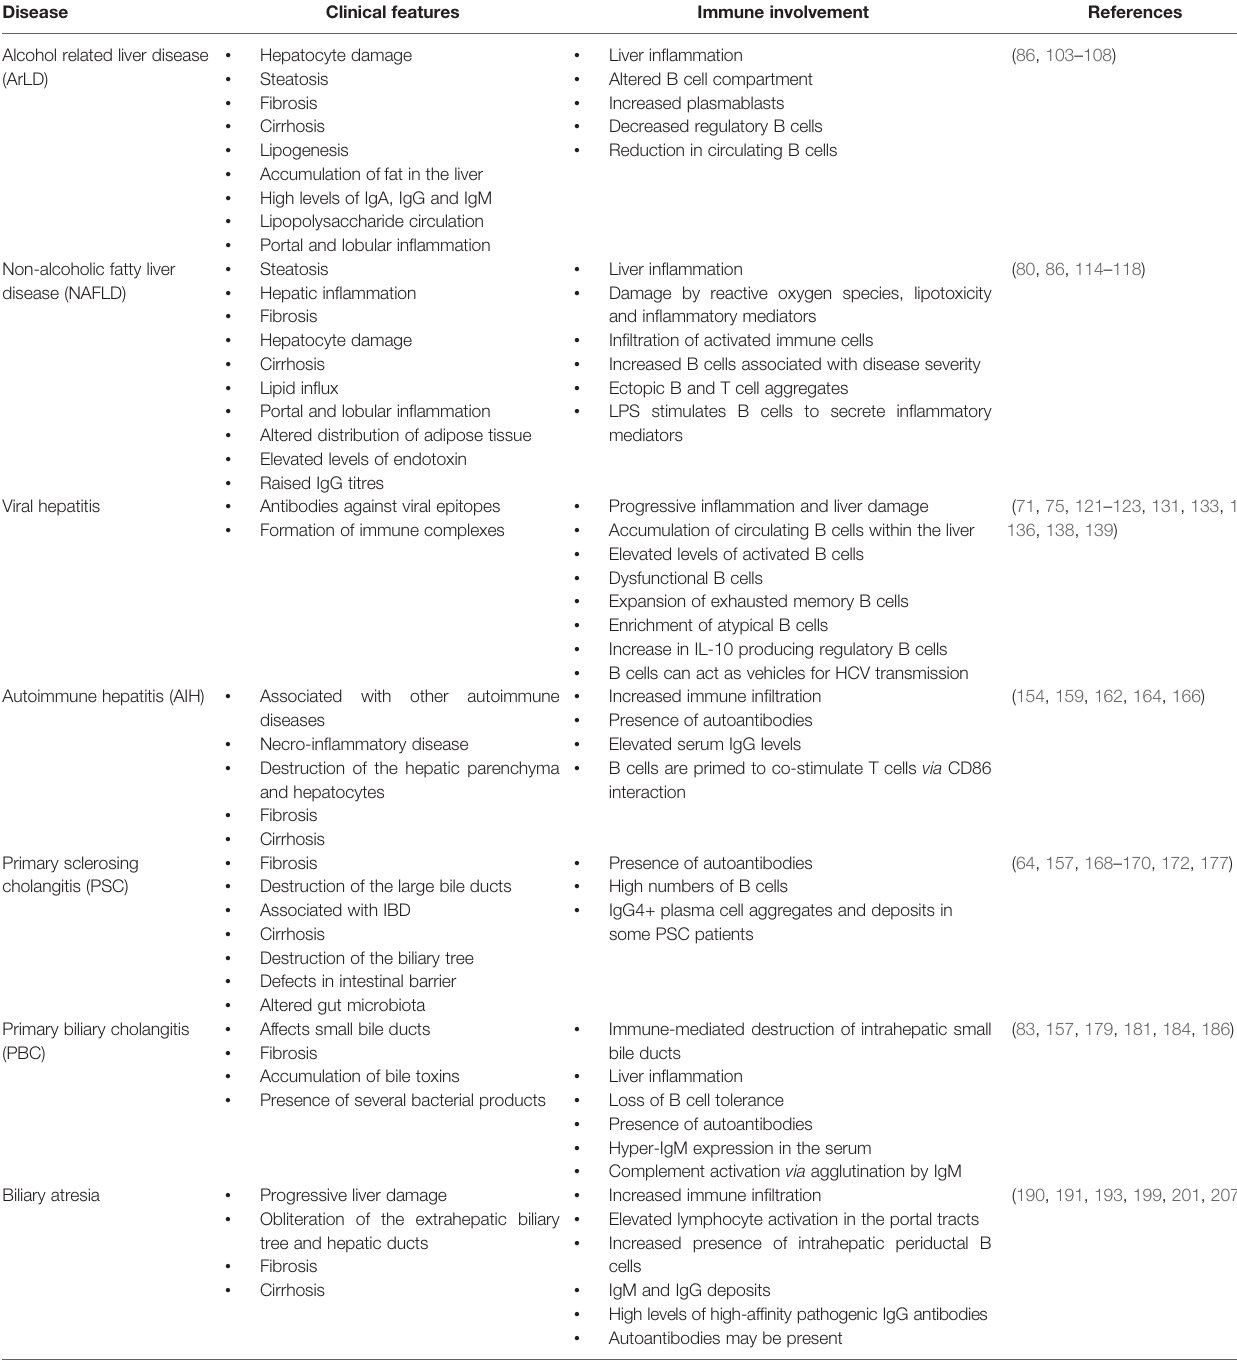
TABLE 2 | Key clinical features and immune involvement in liver